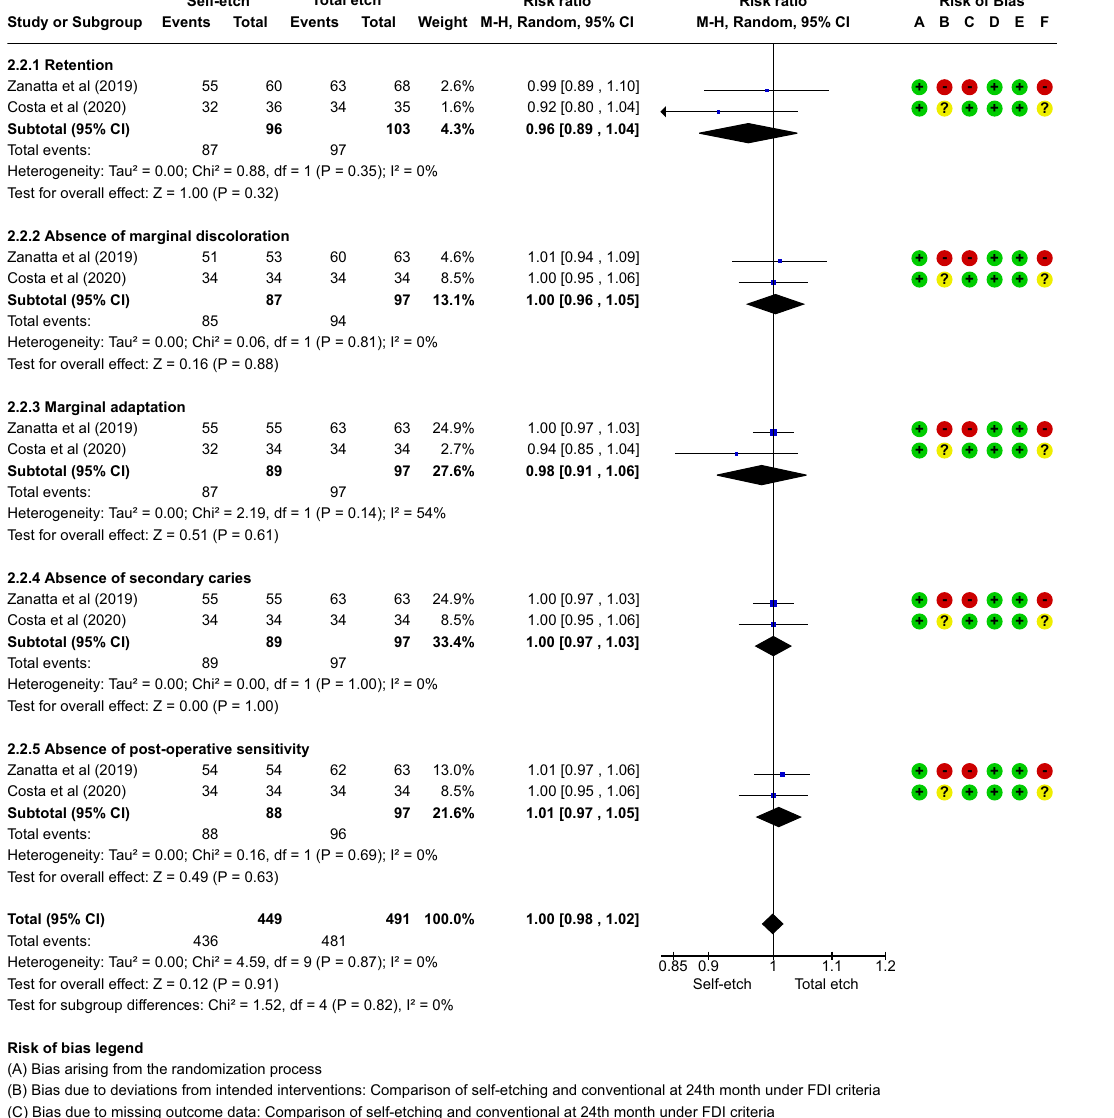
Test for subgroup differences: Chi² = 1.52, df = 4 (P = 0.82), I² = 0%